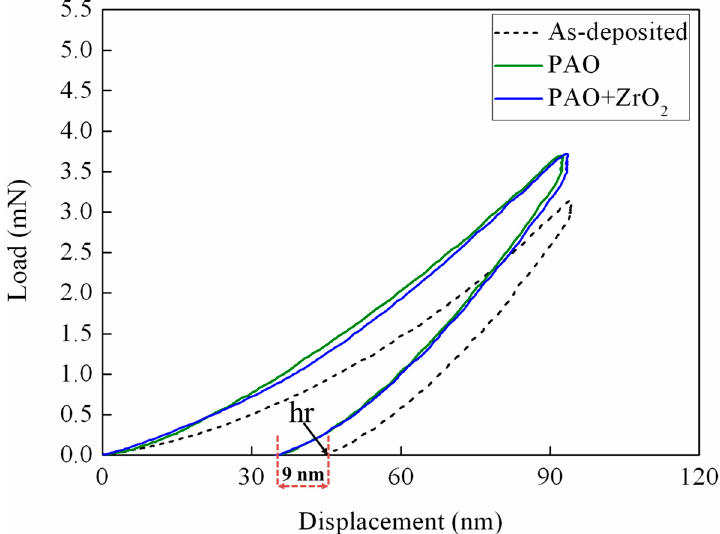
Figure 11. The load − displacement curves obtained from the as-deposited a-C and from the wear tracks on a-C under the lubrication of pure PAO and ZrO 2 -NPs dispersion. The inset shows the average results of hardness (H) and elastic modulus (E) from four parallel tests (Figure S5), hr: residual depth after completed unloading.